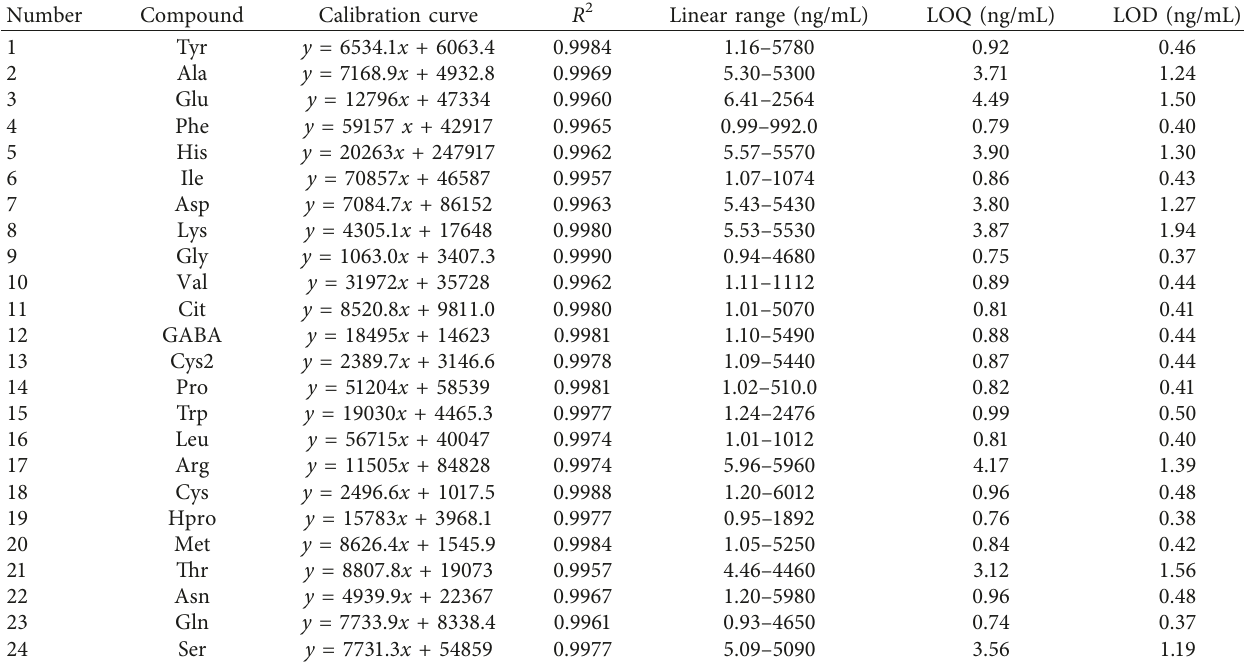
Table 3: Calibration curves, LODs, and LOQs for the 24 compounds.